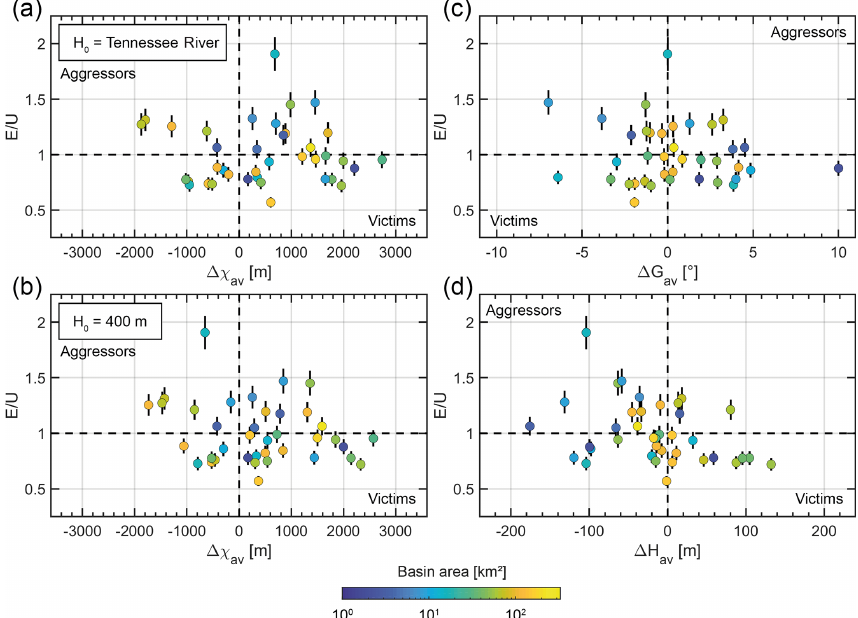
Figure 12. Normalized denudation rates in the Great Smoky Mountains as a function of aggressivity metrics. Original dataset from Matmon et al. (2003b) with E recalculated by Portenga and Bierman (2011). Denudation rates and uncertainties are normalized by the estimated background uplift rate in this region of 0.03mmyr − 1 . Error bars are represented with thin black line. Colour scale indicates basin size. (a, b) Relationship between denudation rates and (cid:49)χ av with a base level corresponding to the Tennessee River and at a fixed elevation of 400m, respectively. (c, d) Relationship between denudation rates and Gilbert aggressivity metrics, (cid:49)G av and (cid:49)H av ,